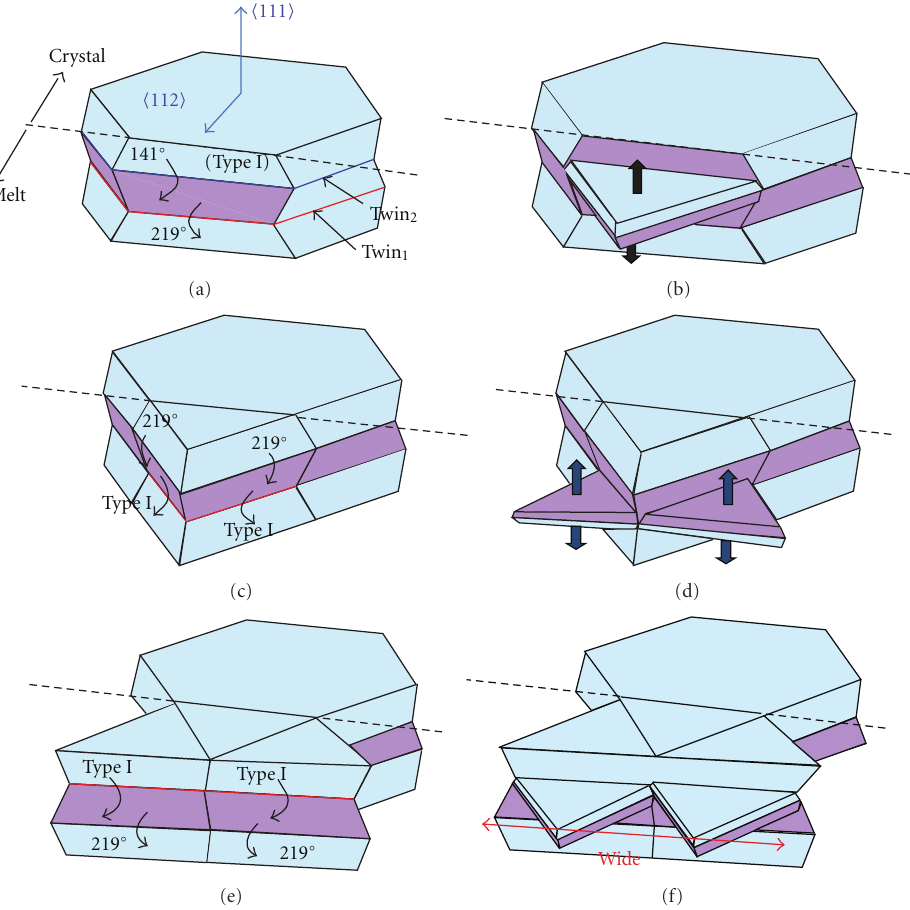
Figure 17: Schematic images of growth of Si (cid:4) 112 (cid:5) dendrite [73, 74]. (a) Equilibrium form of a crystal with two twins, which is bounded by { 111 } habit planes. It is considered that the crystal grows only in the (cid:4) 112 (cid:5) direction for simplicity. A reentrant corner of 141 ◦ angle (type I) appears at the growth surface only at twin 1 . (b) A triangular corner is formed owing to the rapid growth at the type I corner at twin 1 . (c) Crystal growth can continue on the { 111 } flat surface although the rapid growth is inhibited because of the disappearance of the type I corner. When the triangular crystal propagates across twin 2 , two new type I corners are formed at twin 2 . (d) Rapid growth occurs at the two type I corners again, and a triangular corner is formed. (e) After the propagation of the crystal, a type I corner is formed at twin 1 . (f) Rapid growth occurs at a type I corner. A faceted dendrite continues to grow along the (cid:4) 112 (cid:5) direction by repeating the process from (b) to (f). The tip of the (cid:4) 112 (cid:5) dendrite becomes wider with crystal